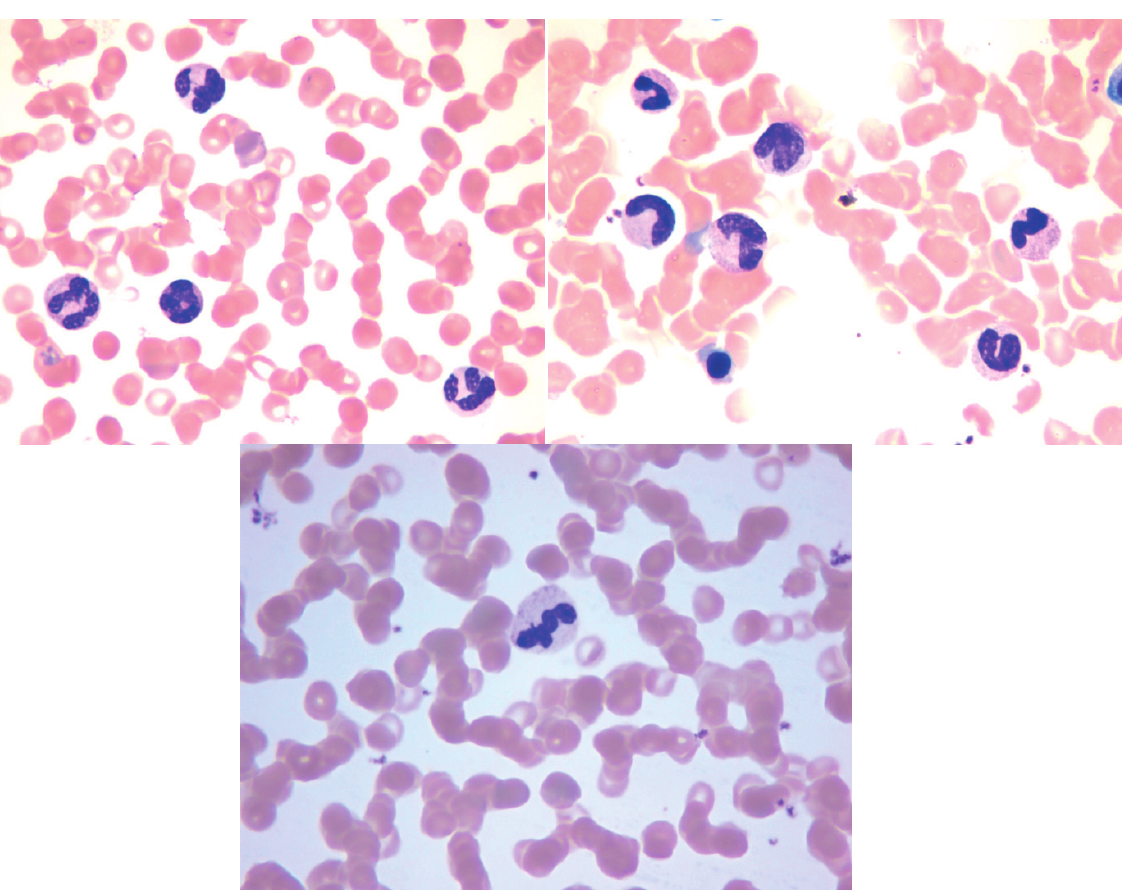
Figure 13. Sample images in the